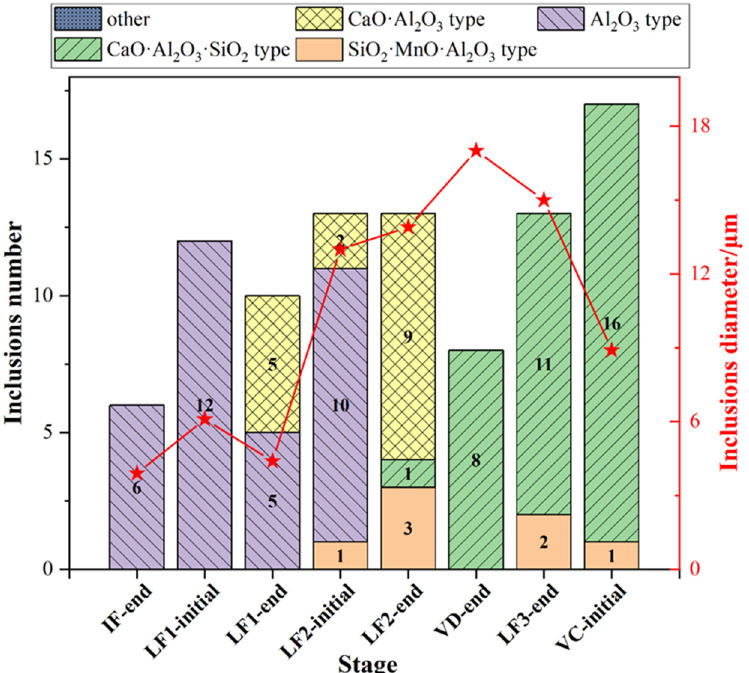
Figure 10. Type and average size distribution of all inclusions at different stages in the optimized plant trial.